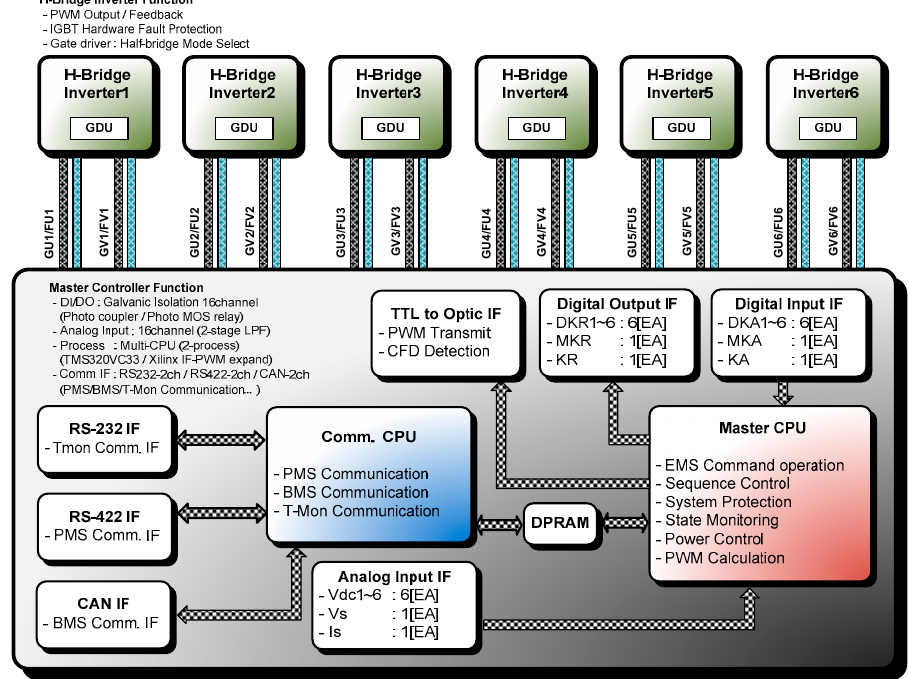
Figure 6. Configuration of MMC-type PCS controller. Table 2. Comparison of Specification between the Proposed PCS and the Existing One.